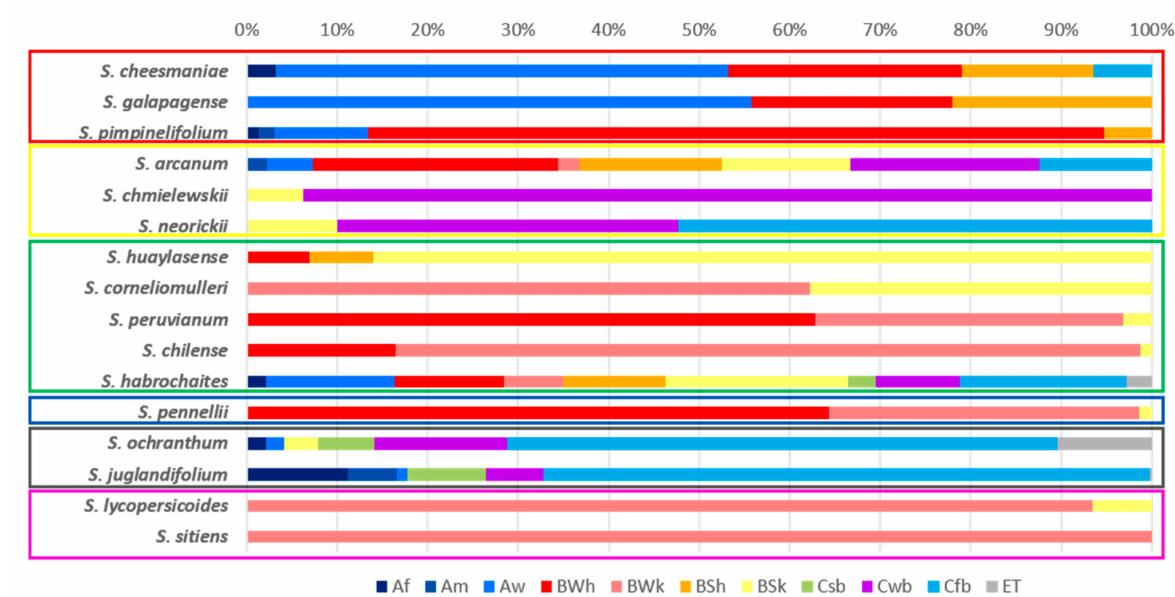
Figure 2. Percentage of climatic type by species according to Beck et al. [31] of 12 wild tomatoes (Sect. Lycopersicon) and 4 closely related species (Sect. Juglandifolia and Sect. Lycopersicoides). Climate classification: Af (tropical, rainforest), Am (tropical, monsoon), Aw (tropical, savannah), BWh (arid, desert, hot), BWk (arid, desert, cold), BSh (arid, steppe, hot), BSk (arid, steppe, cold), Csb (temperate, dry summer, warm summer), Cwb (temperate, dry winter, warm summer), Cfb (temperate, no dry season, warm summer), ET (polar, frost). Within each rectangle, species that belong to the phylogenetic groups proposed by Peralta et al. [1]: Red = Lycopersicon, yellow = Arcanum, green = Ericopersicon, blue = Neoricopersicon, gray = S. sect. Juglandifolia , pink = S. sect. Lycopersicoides